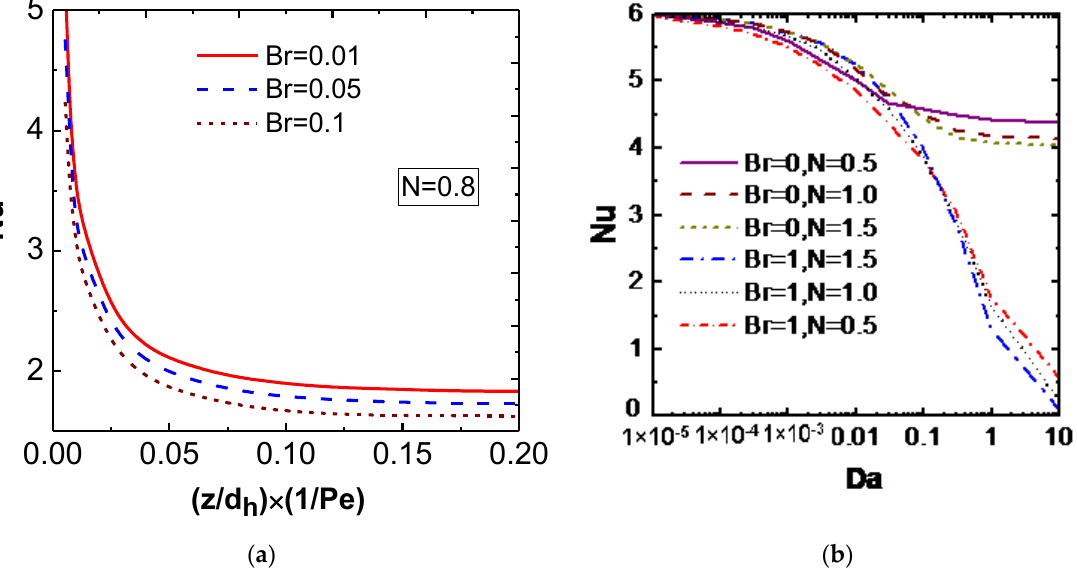
Figure 2. Average Nusselt number as a function of Br and N. ( a ) Nu vs. (z/d h ) (1/Pe) [153] ( b ) Nu vs. Da [139].